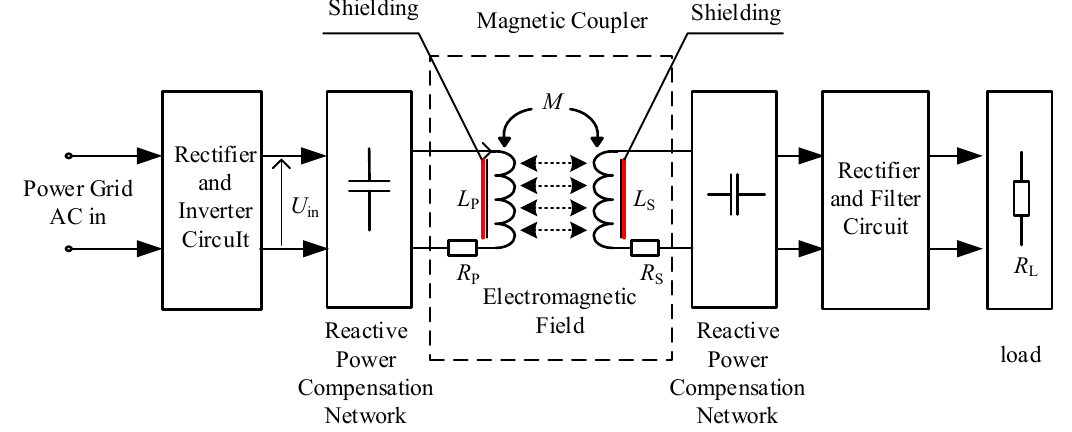
Figure 1. The schematic diagram of the inductively coupled wireless power transfer (WPT) system. Parallel–series topologies are adopted in this circuit—transmitting coil and compensation network are in parallel; and the receiving coil and compensation network are in series. In Figure 1, L P and L S are the inductance of transmitting coil and receiving coil. R P and R S are the internal resistance of transmitting coil and receiving coil. U in is the output voltage of electric energy after rectification and high-frequency inversion. M is the mutual inductance between transmitting coil and receiving coil. k is the coupling coe ffi cient. R L is the load resistance. I L is the current of R L . I P is the current